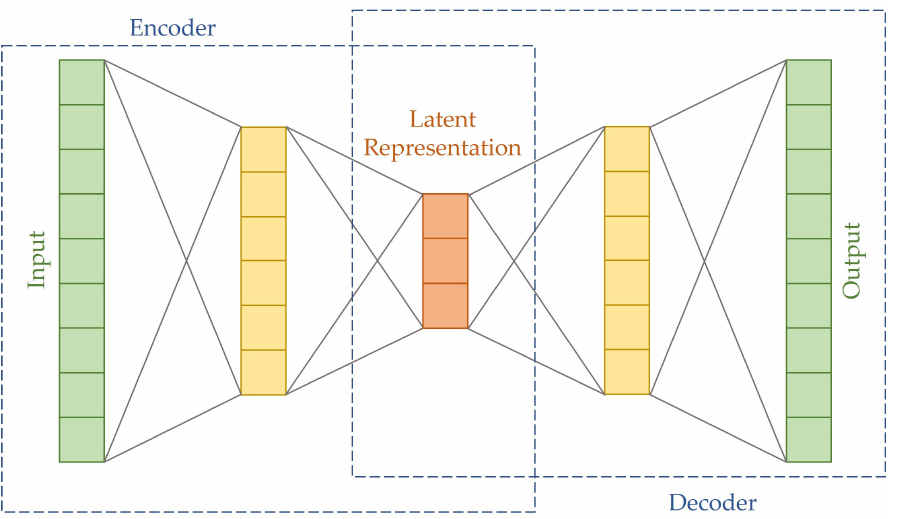
Figure 5. A typical autoencoder architecture consisting of encoder (extracting features from the input in the latent space) and decoder (reconstructing the original input from the latent